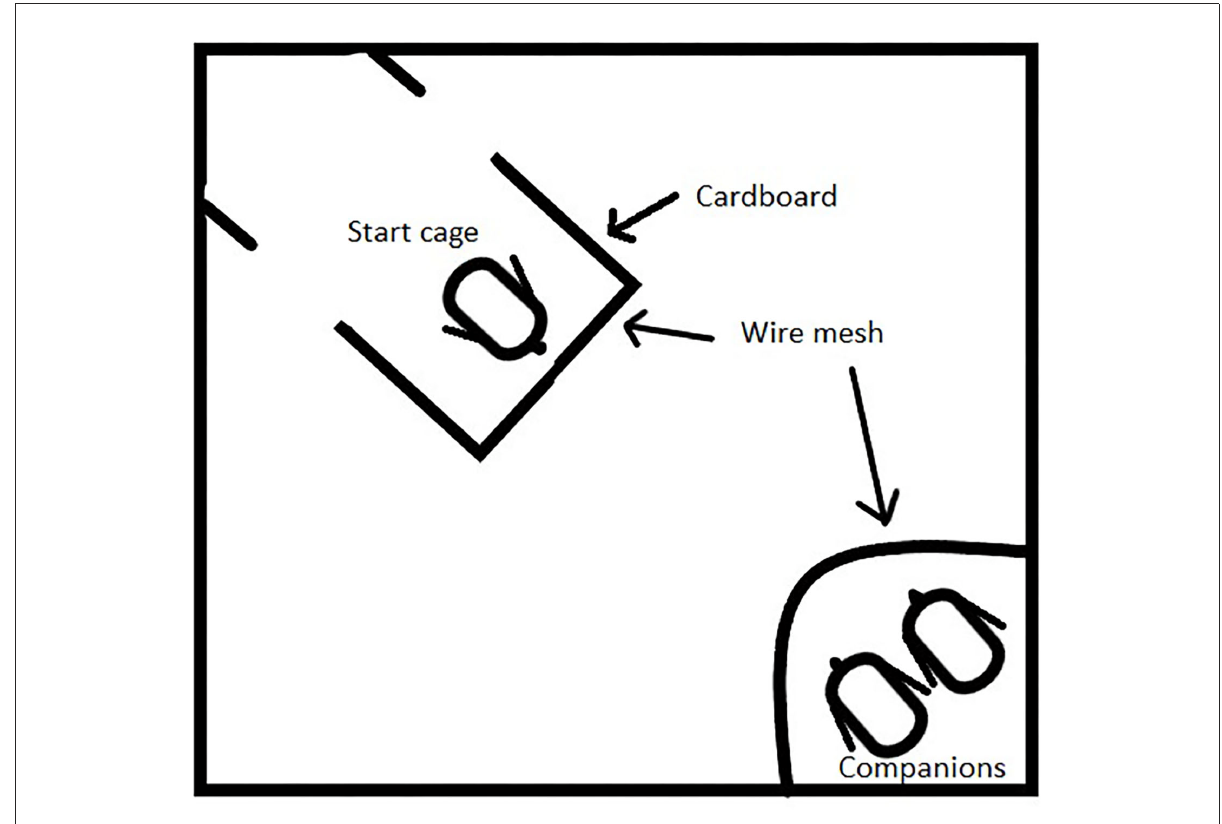
FIGURE3 Spatial learning arena. A companion cage with two companions were put in one corner. The starting box in the corner diagonally had wire mesh toward the companions and two openings behind the chick’s starting position.